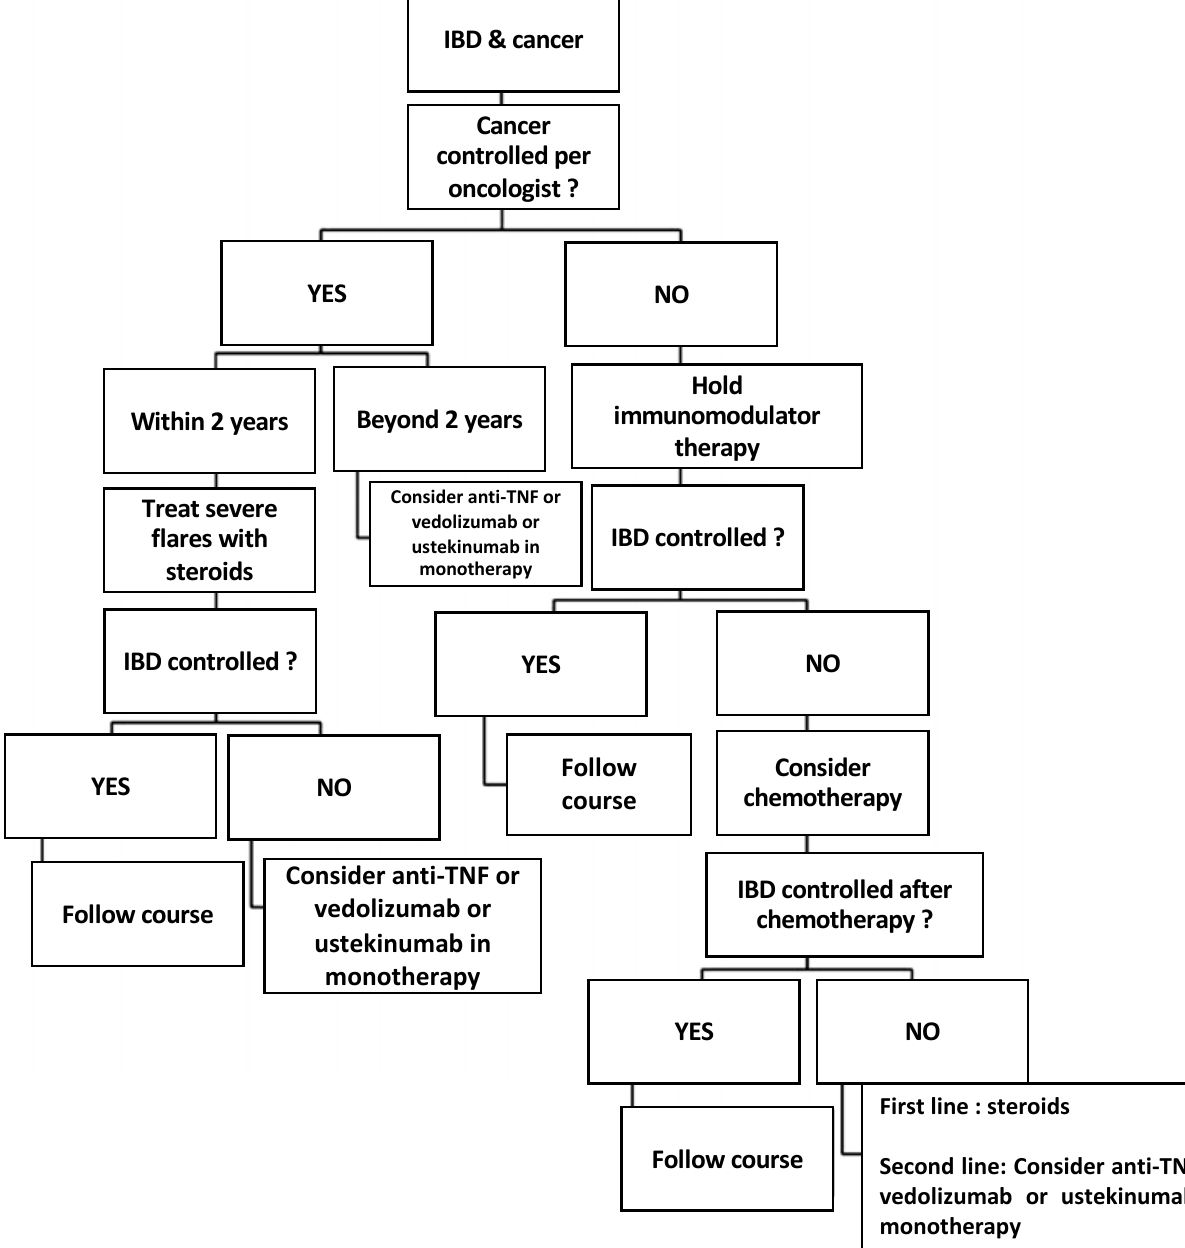
Figure 5. Updated algorithm for managing IBD patients with previous or current malignancy (adapted from reference